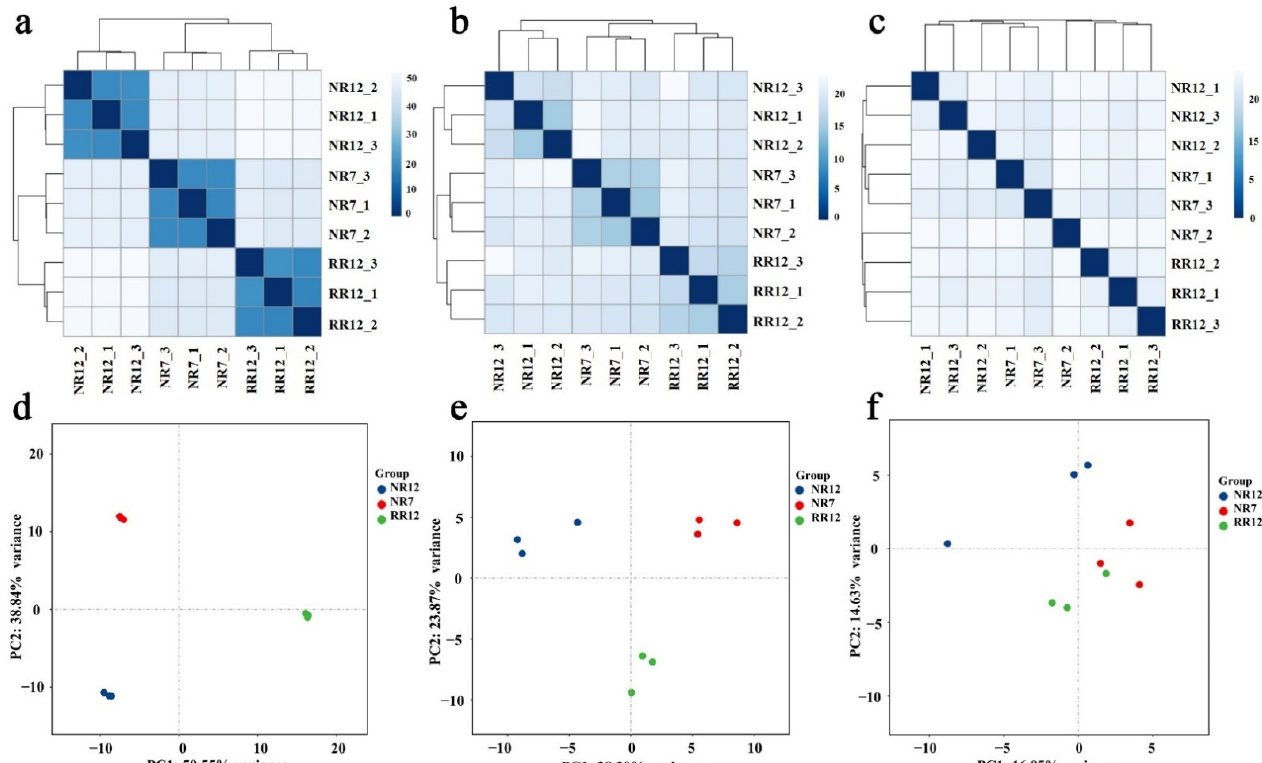
Figure 3. Correlation and PCA analyses of different samples. The sample-to-sample correlation analyses in mRNA ( a ), lncRNA ( b ), and circRNA ( c ). The horizontal axis and the vertical axis represent the corresponding sample names, and the color represents the size of the correlation coefficient. The PCA analyses among mRNA ( d ), lncRNA ( e ), and circRNA ( f ).